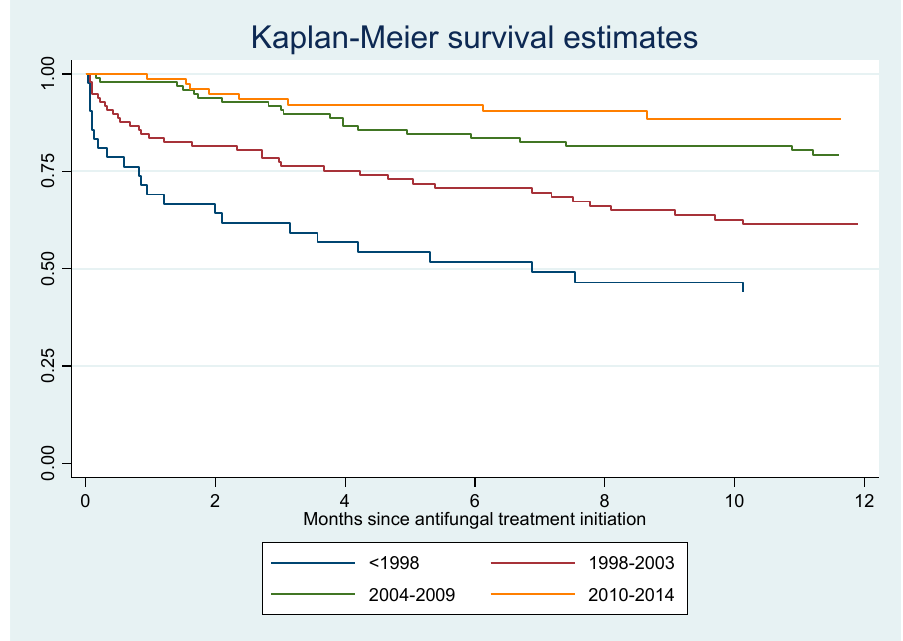
Figure 3. Incidence of death within 12 months after antifungal treatment initiation for HIV-associated disseminated histoplasmosis. 1981–2014, French Guiana.